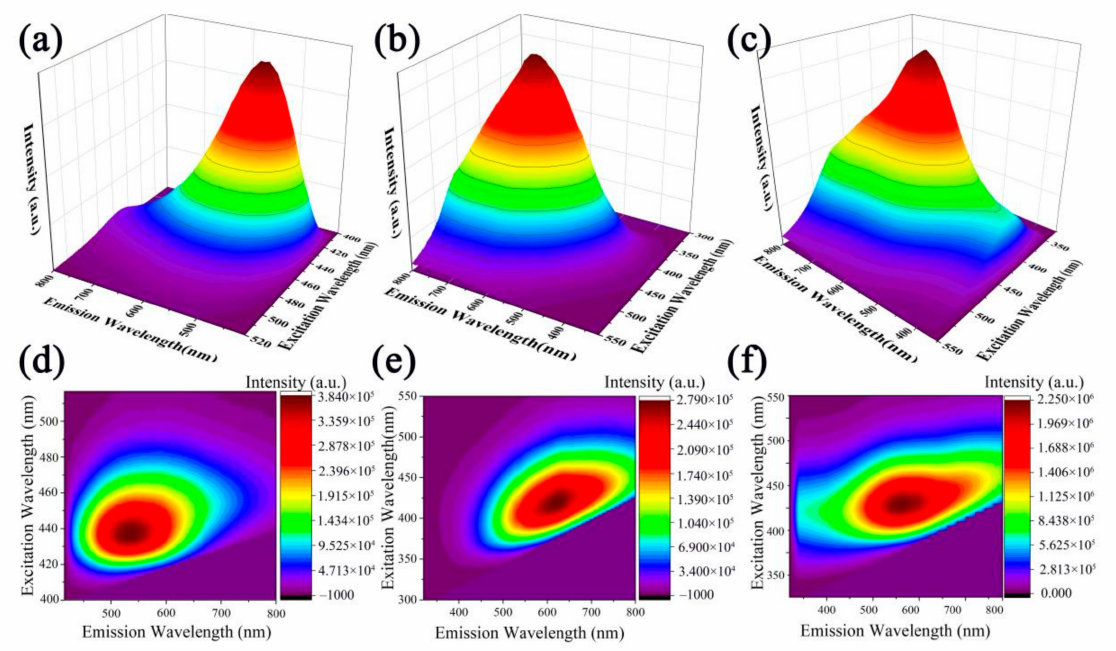
Figure 2. The fluorescence emission-excitation 3D map of ( a ) p-CNDs, ( b ) n-CNDs, ( c ) CNDs aerogel. The 2D contour map of the fluorescence emission spectrum of ( d ) p-CNDs, ( e ) n-CNDs, ( f ) CNDs